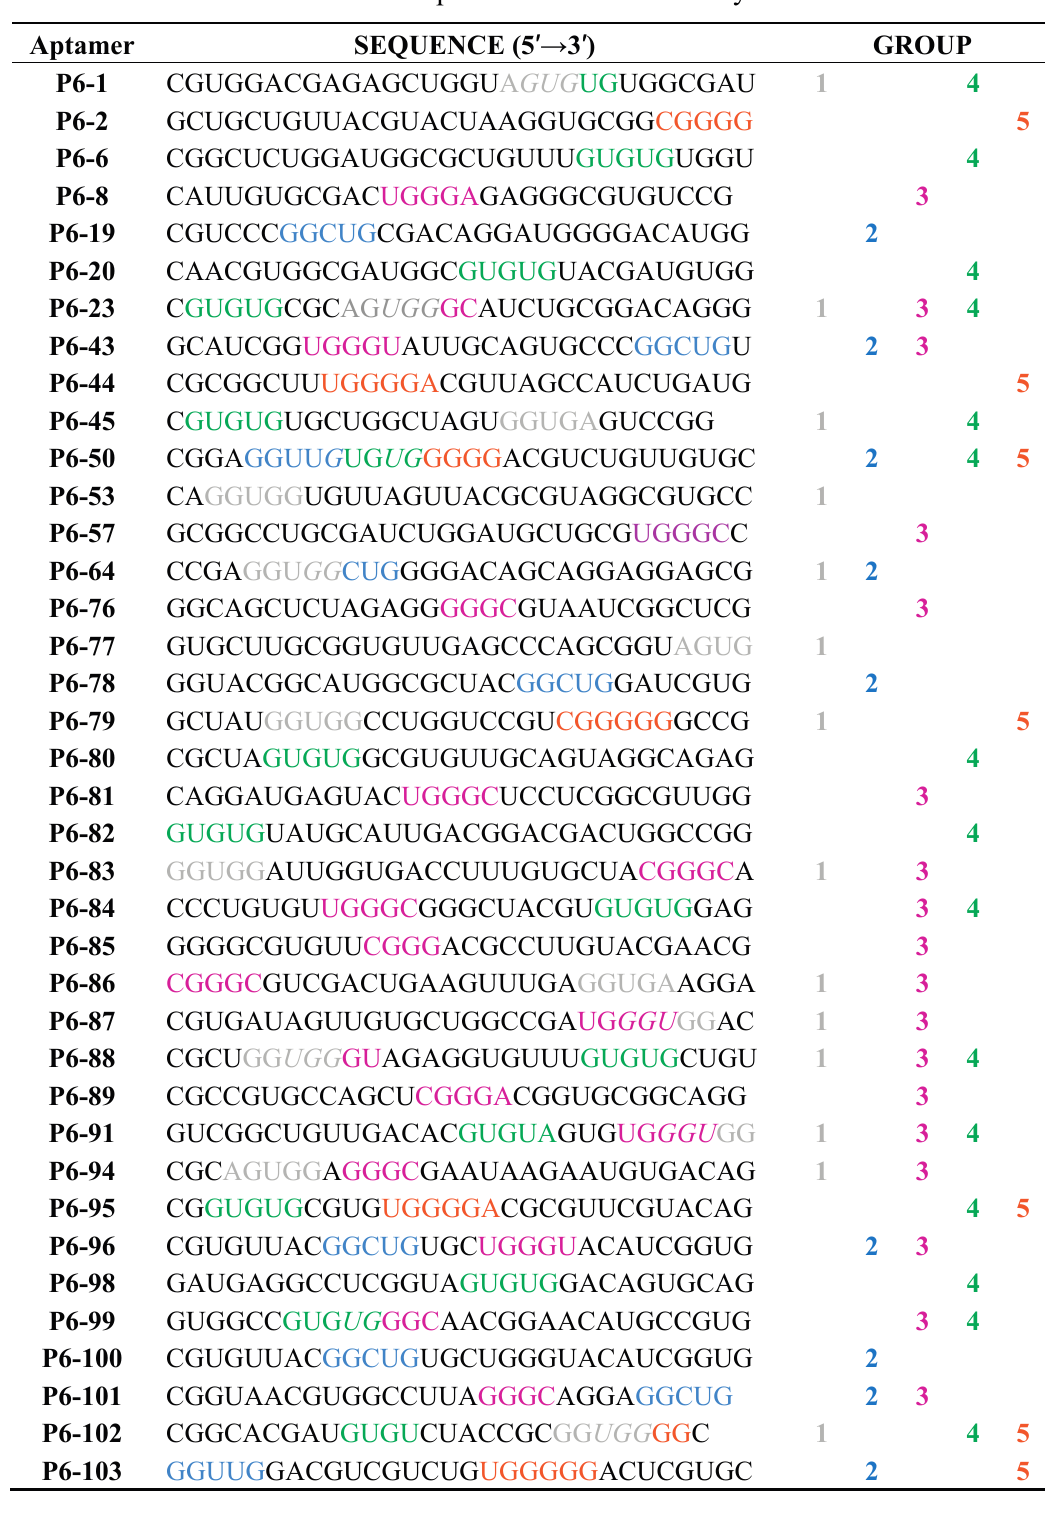
Table 1. Aptamers used in this